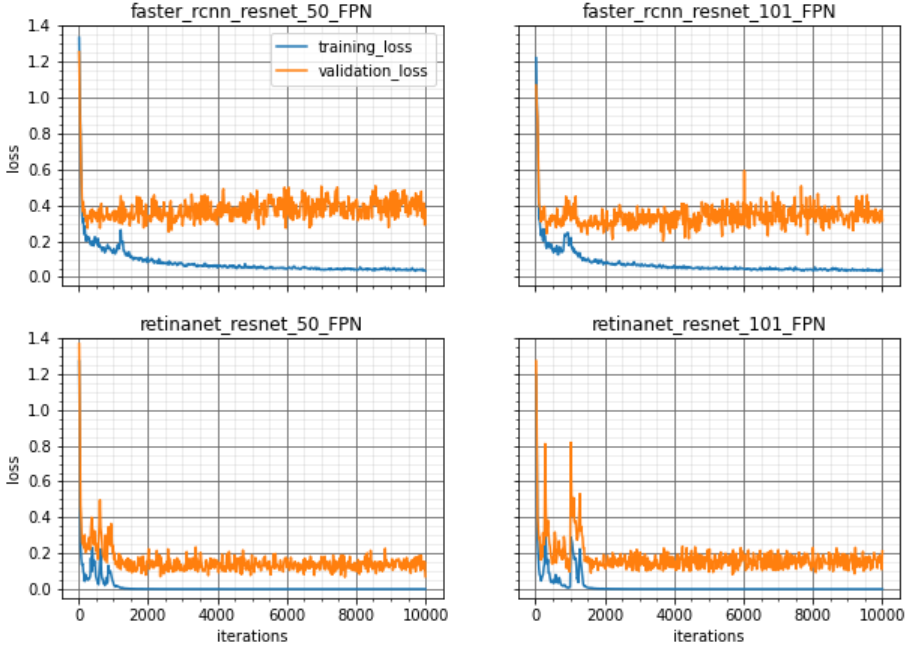
Figure 4. Training and Validation Loss values for all methods to the division 66-15-19 over 10,000 iterations of training model.